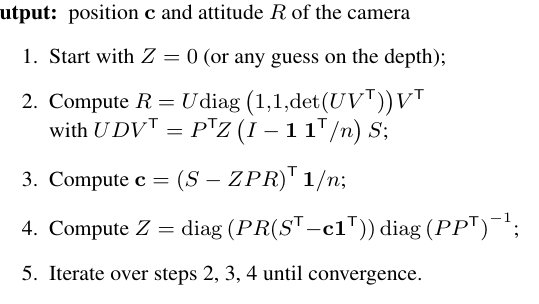
Algorithm 1 P ROCRUSTEAN E XTERIOR O